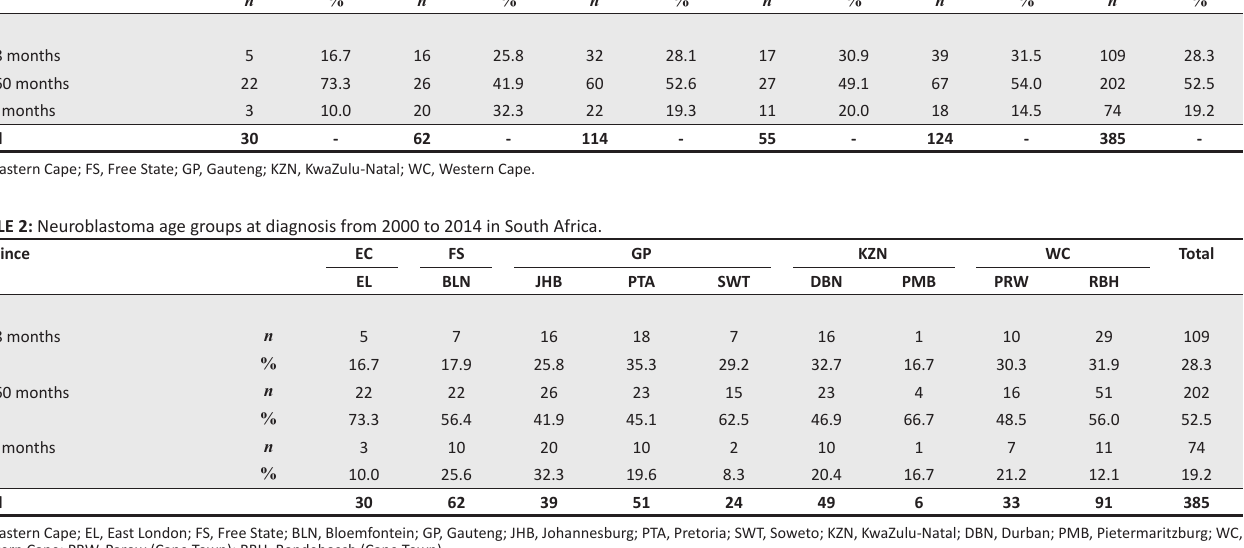
TABLE 1: Neuroblastoma age groups at diagnosis from 2000 to 2014 per province in South Africa. Province EC FS GP KZN WC Median in months (IQR)